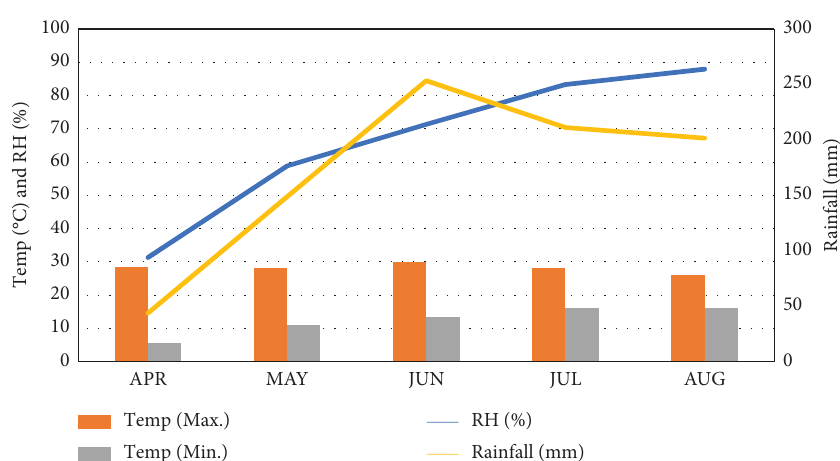
Figure 2: Agroclimatic characteristics of the experimental